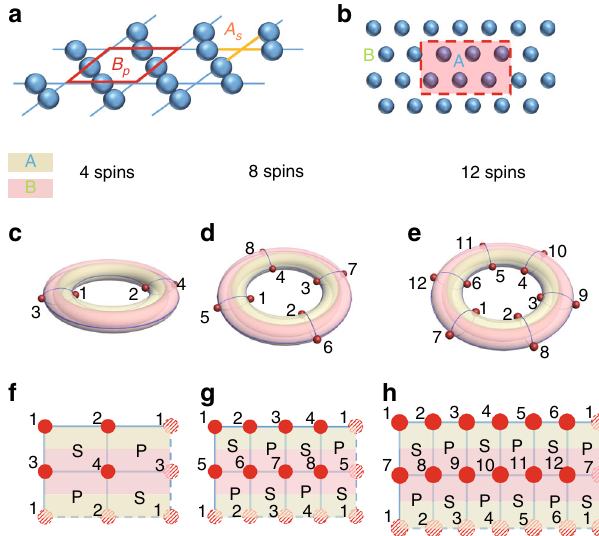
Fig. 1 Separation of the toric code model into two subsystems. a the schematic diagram of the toric code model. A blue sphere stands for a spin, A s and B p represent two kinds of four-body interactions in the Hamiltonian H 0 . b the total system is divided into subsystems A and B. The boundary is shown by red dashed line. In c – e the yellow region is the subsystem A, and the pink region is the subsystem B. Each red sphere represents one spin. c – e the torus geometry for square lattices with 4, 8, and 12 spins. The periodic boundary conditions are taken. f – h the unfolded forms of the corresponding torus in c – e , respectively. The shadow spheres are drawn to show the periodic boundary condition. Here, the operator S represents the operator A s and P represents the operator B p . Two disconnected boundaries exist between subsystem A and B, and the lengths for each boundary between subsystem A and B in f – h are 2, 4, and 6,